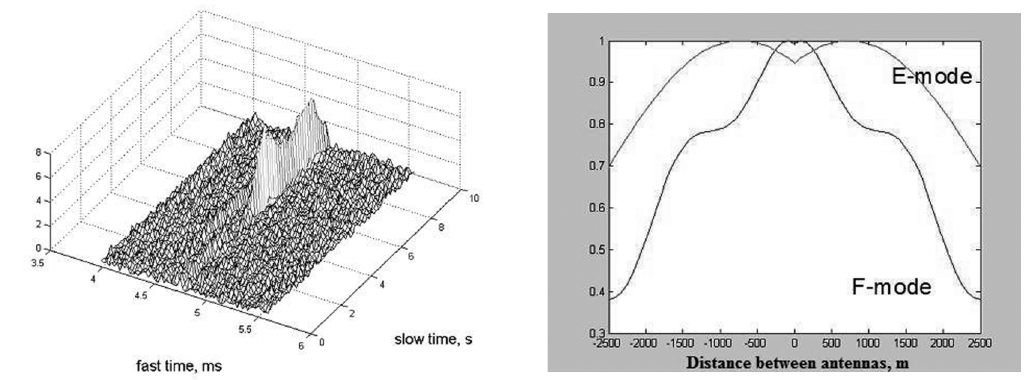
Fig. 4.a,b. Received signal power with added noise for a 9MHz carrier with 20kHz bandwidth and σ N2 =2.10 -5 (left frame), and correlation coefficient versus antenna separation for both E and F modes (right frame).